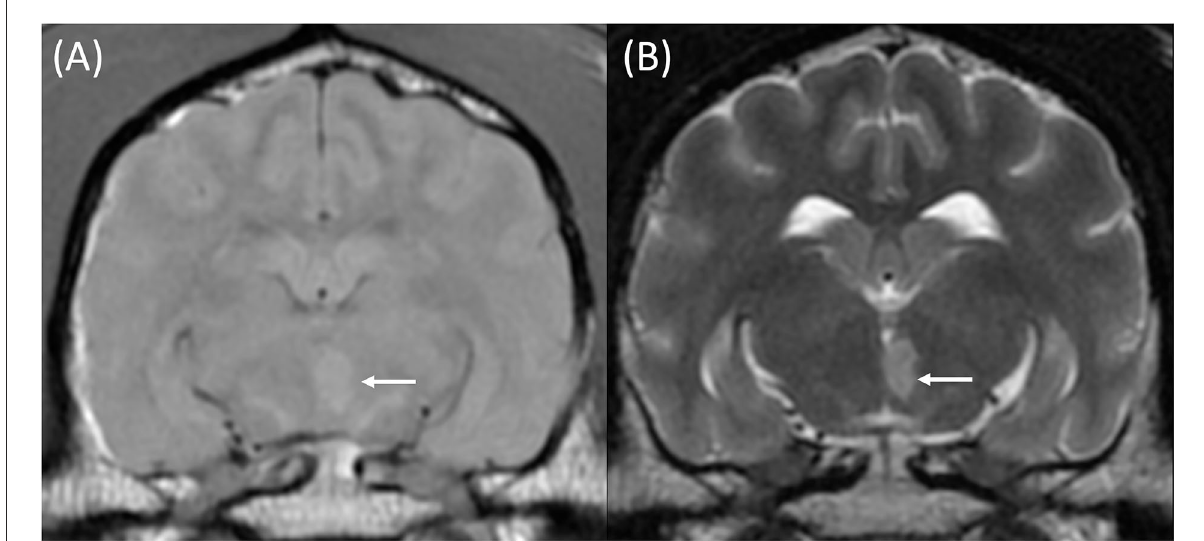
FIGURE4 T1w pre-contrast (A) and T2w (B) transverse images at the level of the piriform lobes of an 11-year-old female neutered Labrador Retriever that presented with acute onset left-sided central vestibular deficits. The MRI was performed within 3 days following the onset of clinical signs. A well-defined T1w pre-contrast and T2w hyperintense lesion is centered on the caudomedial aspect of the left thalamic lobe (A + B, white arrows). This was most likely compatible with a territorial infarction of the left caudal perforating